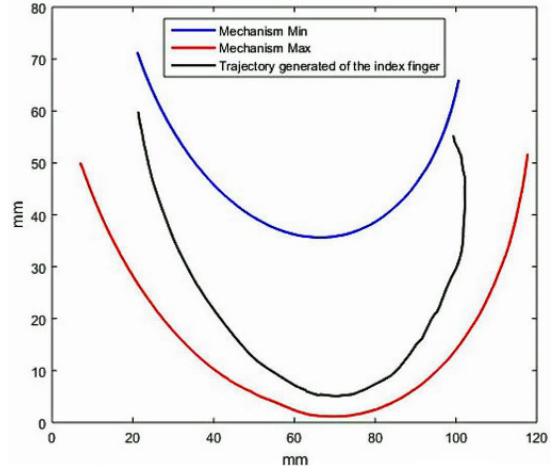
Figure 13. Comparison of the workspace and the index finger trajectory.